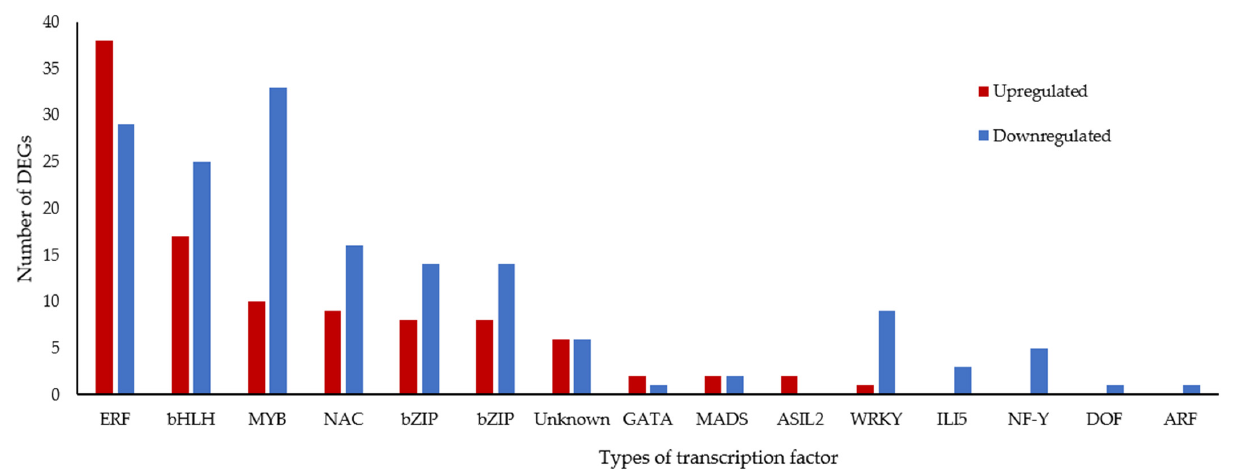
Figure 8. The number of waterlogging-related transcription factors that are classified according to their protein families. [ARF, auxin response factor; bHLH, basic helix-loop-helix; bZIP, basic zinc leucine zipper domain; DREB, dehydration-responsive element binding; ERF, ethylene response factor; MYB, myeloblastosis; NAC-NAM, ATAF, and CUC; ZF-TF, zinc finger transcription factor].